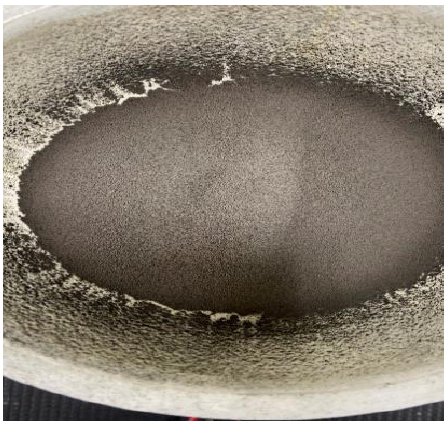
Figure 11. Schematic diagram of the NaBH 4 + Co 2+ catalyst after ball milling.